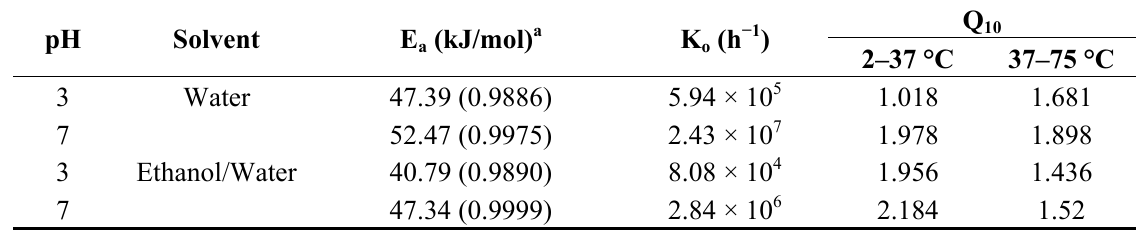
Table 2. Effect of temperature on the degradation of anthocyanins from cranberrybush fruits